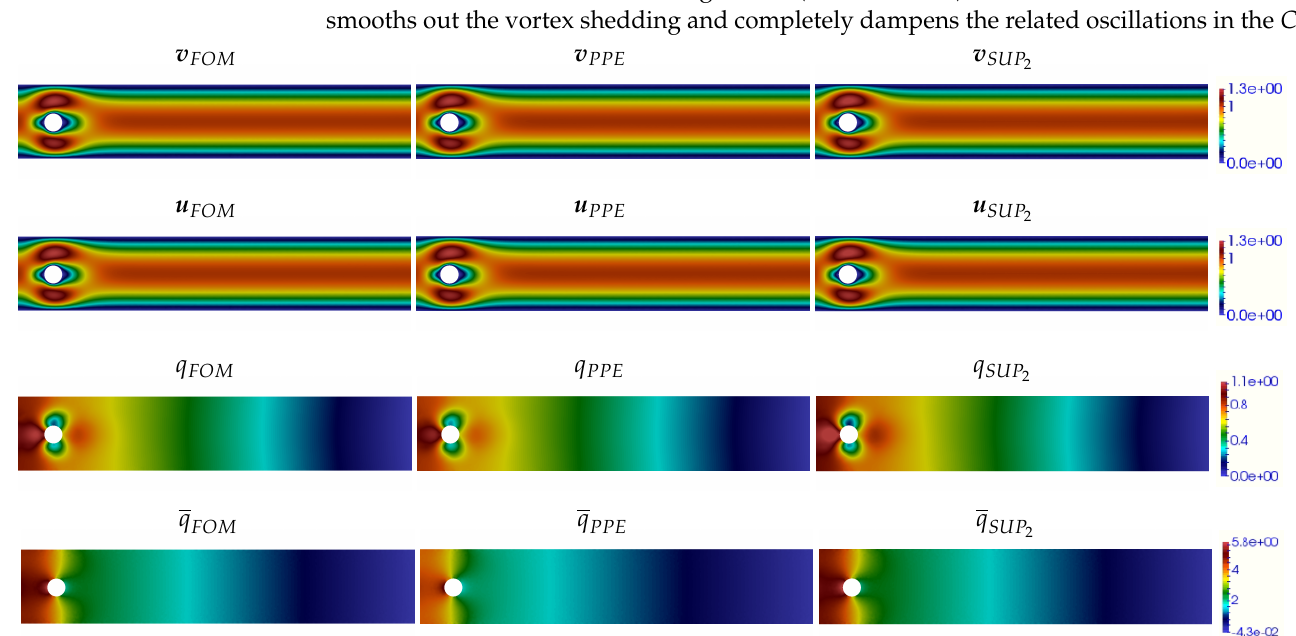
Figure 3. Velocity fields u (first row) and v (second row) and pressure fields q (third row) and q (fourth row) at time t = 2 computed by FOM (left), PPE-ROM (center), and SUP 2 -ROM (right).